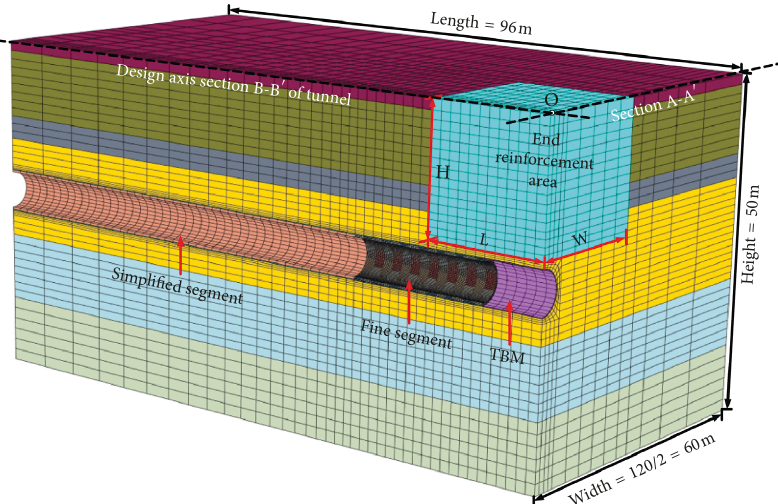
Figure 18: Schematic diagram of soil reinforcement at the shield arrival stage.